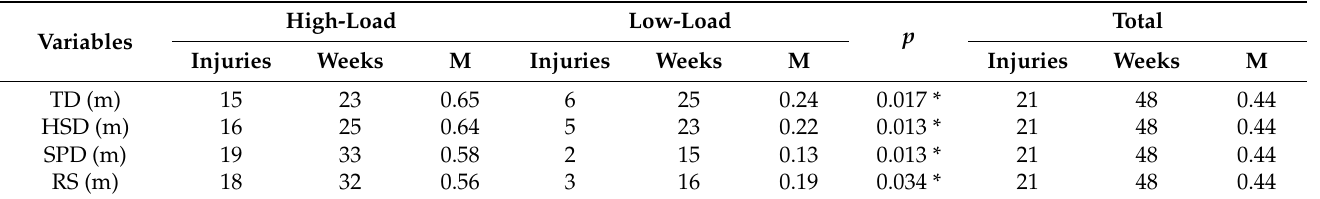
Table 2. Relation between TD, HSD, SPD, and RS with non-contact injuries (mean).